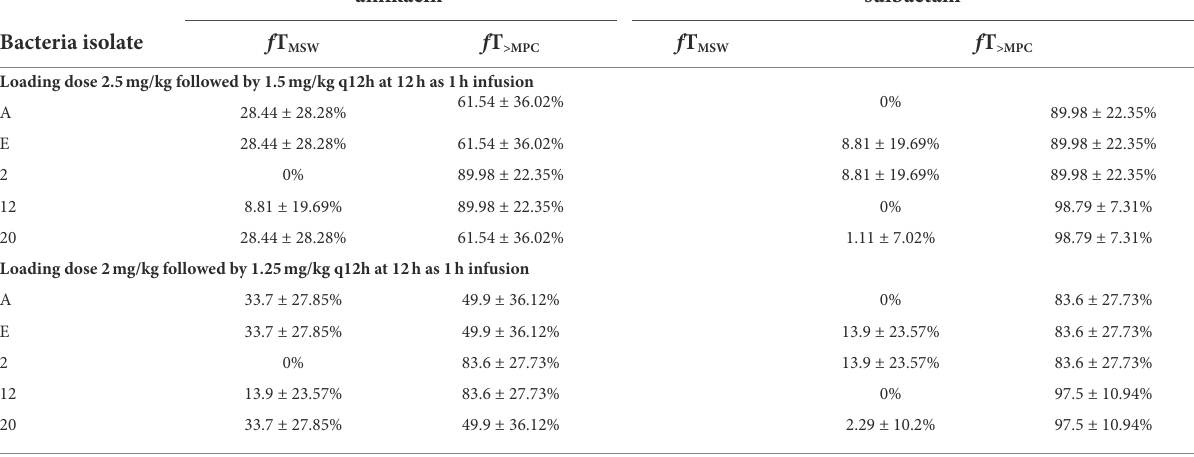
TABLE 5 Pharmacodynamic parameters f T MSW and f T >MPC based on MIC and MPC of polymyxin-B ‡ in plasma against five Acinetobacter baumannii isolates harboring OXA-23 and other serine- β -lactamases. Double-combination of polymyxin-B with amikacin ‡